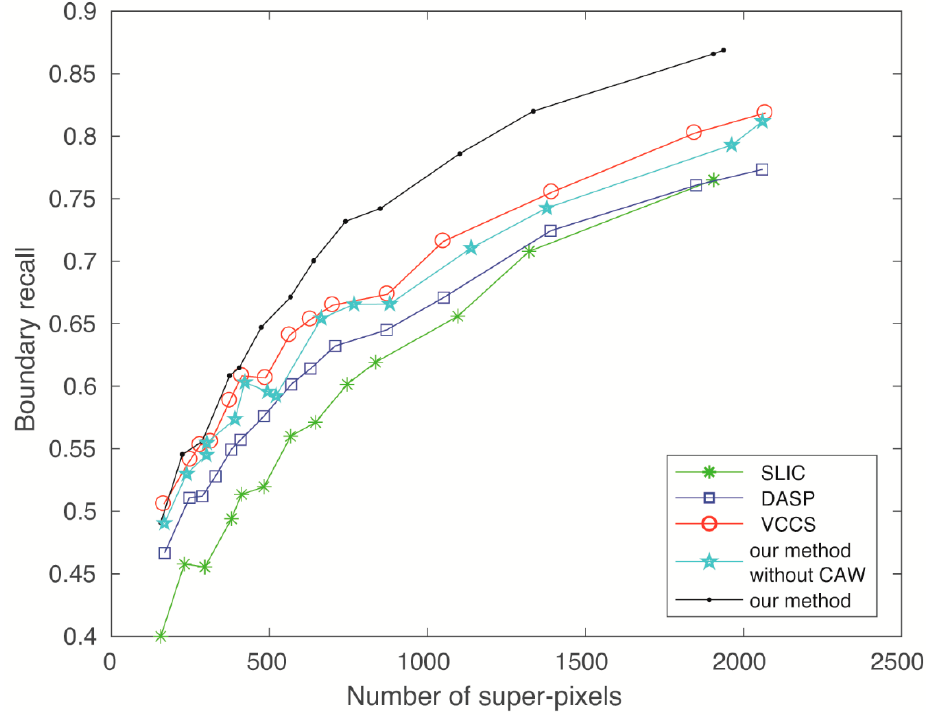
Figure 5. The boundary recall of the four superpixel methods.